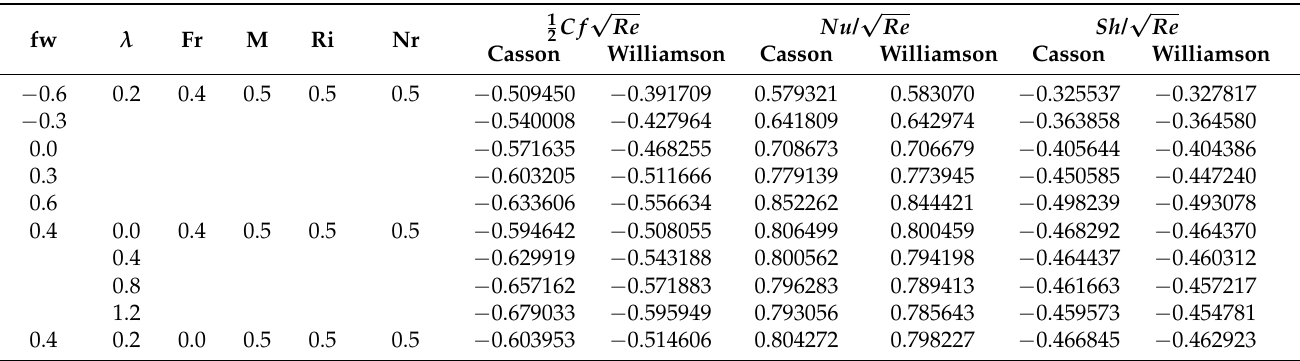
Table 1. The skin friction coefficient, local Nusselt number and local Sherwood number for fw , λ , Fr , M , Ri and Nr for both